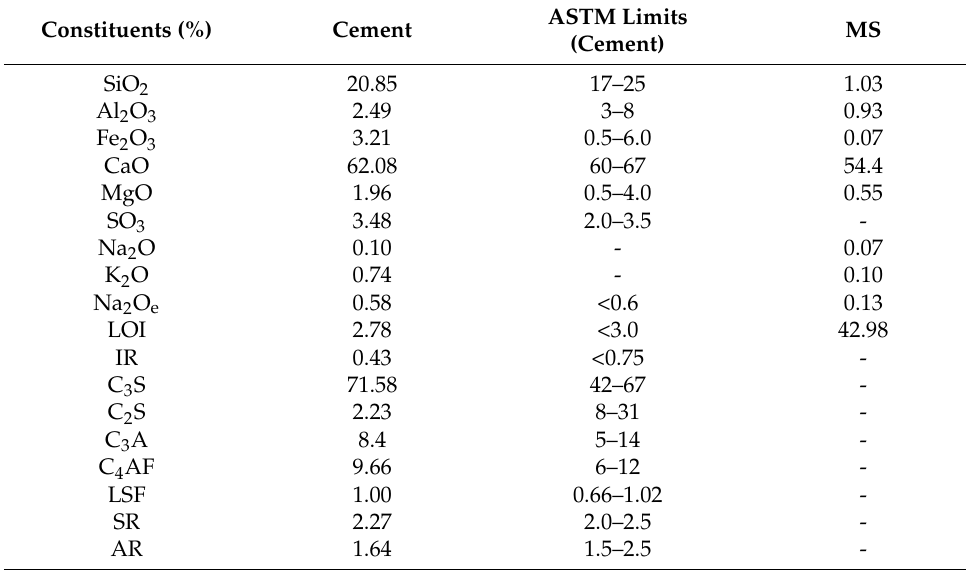
Table 2. Composition of cement and MS (chemical